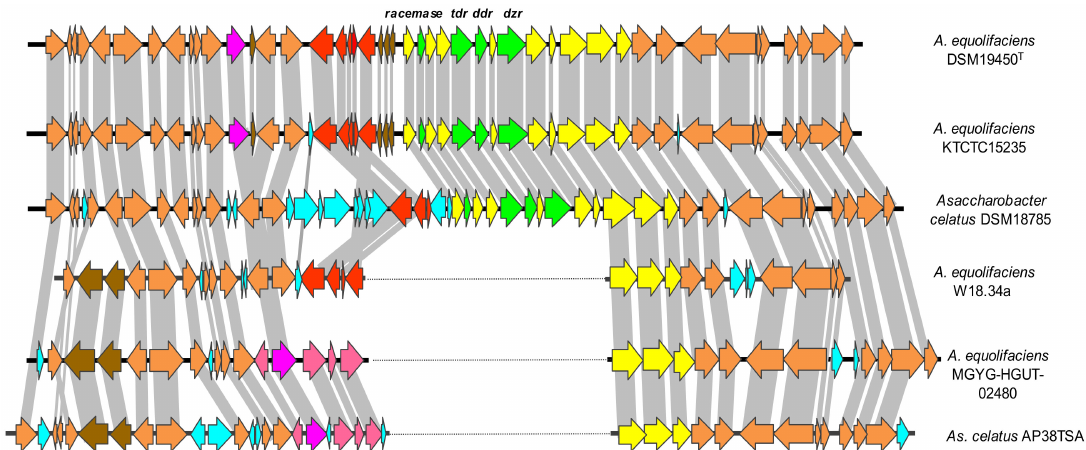
Figure 4. Diagram showing the genetic organization of upstream and downstream ORFs within the equol gene cluster in several strains of A. equolifaciens and As. celatus . In green, genes coding for well-known proteins involved in equol biosynthesis: racemase ( racemase ), daidzein reductase ( dzr ), dihydrogenistein reductase ( ddr ), and tetrahydrodaidzein reductase ( tdr ); in yellow, genes coding proteins with activity in daidzein metabolism; in light brown, conserved genes along all analyzed strains; in dark brown, red, pink, and purple, genes present in certain strains but not in others; and in pale blue, strain-specific genes. A. equolifaciens DSM19450 T and As. celatus DSM18785 T have been reported to be equol producers, while A. equolifaciens W18.34a does not produce